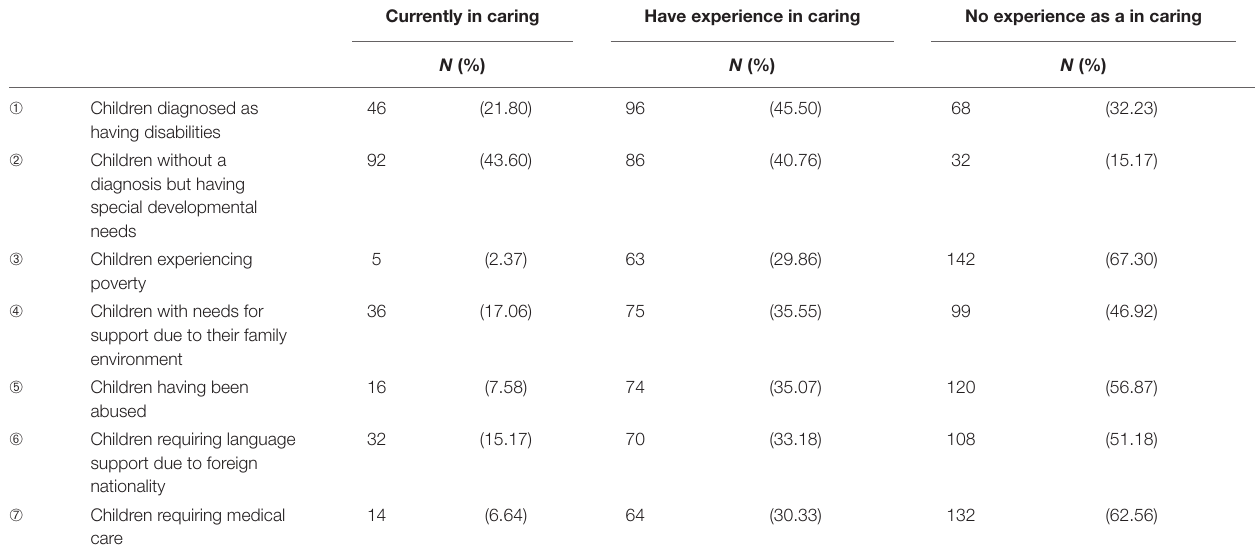
TABLE 2 | Experience in caring for children with special